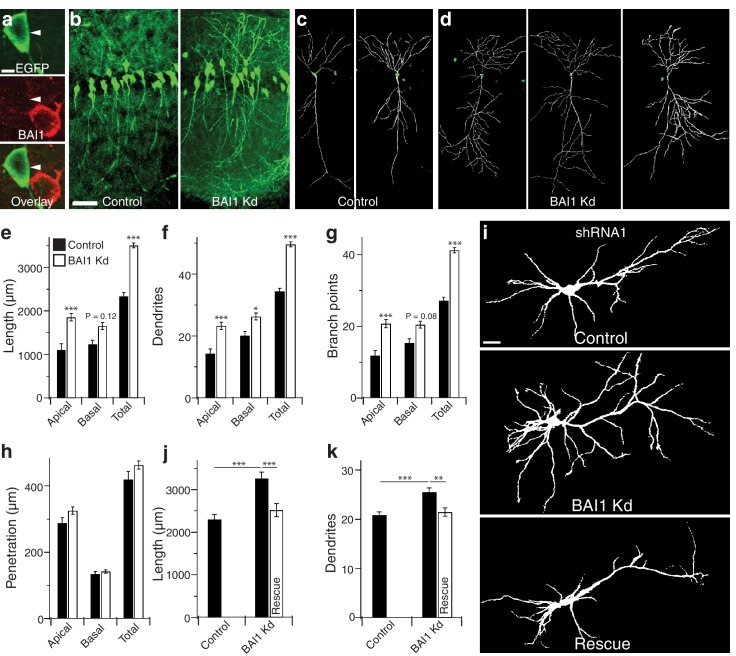
BAI1 restricts dendrite growth in the developing hippocampus and hippocampal cultures.(a) Representative in vivo images showing optical sections through the centers of neuronal somata from mice transfected with EGFP and shRNA against Adgrb1 and stained for BAI1. Note that the transfected neuron expressing EGFP and shRNA has substantially lower BAI1 staining that the neighboring untransfected neuron, indicating successful BAI1 knockdown. (b) 100 µm thick slices of dorsolateral CA1 from mice transfected with EGFP (Control) or EGFP and shRNA against BAI1 (BAI1 Kd). Bar is 50 µm. c and d Reconstructions of representative control (c) and BAI1 Kd (d) dendritic arbors from slices like those in b. (e) Summary data for dendrite length. (f) Summary data for dendrite number. (g) Summary data for branch points. (h) Summary data for dendrite penetration. Total number of neurons: 21 (N = 3) for control and 41 (N = 4) for BAI1 Kd. (i) Representative images of neurons expressing EGFP alone (control) or with shRNA against Adgrb1 (BAI1 Kd) or with shRNA against BAI1 and RNAi-resistant BAI1 (Rescue). Images are masked to remove axons and dendrites from other neurons. Bar is 20 µm. (j) Summary data for total length of cultured neurons. (k) Summary data for total dendrite number in cultured neurons. Total number of neurons in j and k: 118 for control neurons, 106 for BAI1 Kd neurons, and 65 for rescue neurons (N = 7). Data are represented as mean ± s.e.m. (***p<0.001) Detailed statistics are found in Figure 1—source data 1.10.7554/eLife.47566.010Figure 1—source data 1.Statistical summary for Figure 1: ANOVA and key Tukey post-hoc tests and N and n values for Figure 1e–h,j–k.10.7554/eLife.47566.007Figure 1—source data 2.Individual values for in vivo and cultured neurons demonstrating the effects of BAI1 loss on arbor growth (Figure 1e–h,j–k).10.7554/eLife.47566.008Figure 1—source data 3.Quantification of Western bands showing expression levels of BAI1, BAI2, and BAI3 (Figure 1—figure supplement 1d).10.7554/eLife.47566.009Figure 1—source data 4.Extended individual values for in vivo and cultured neurons showing the effects of BAI1 loss on arbor growth (Figure 1—figure supplement 1a,b,e,g,h,i,j).